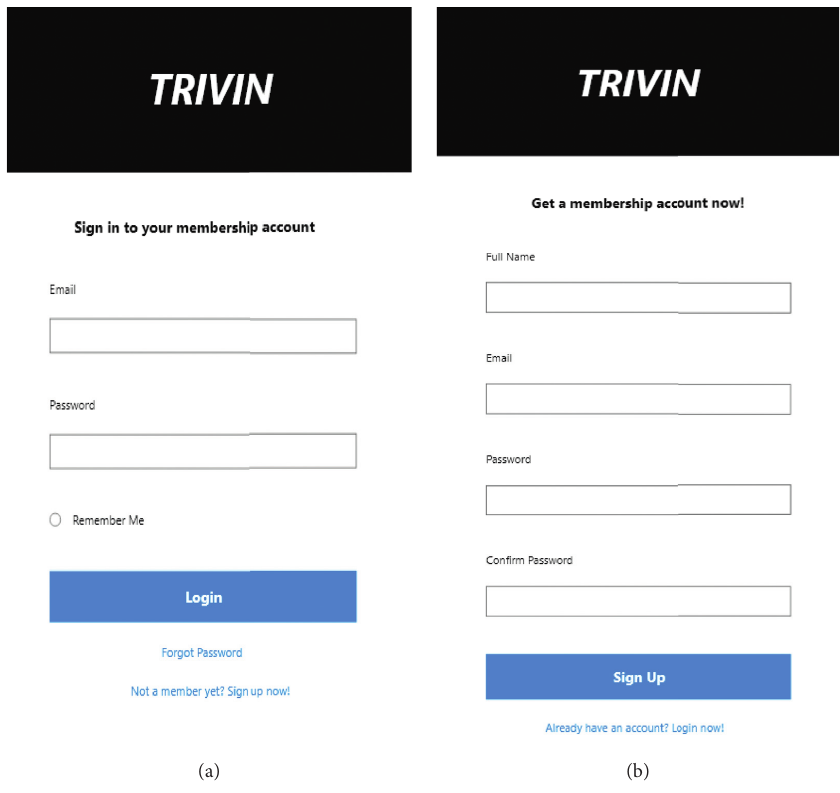
Figure 3: (a) Login page user interface and (b) register page user